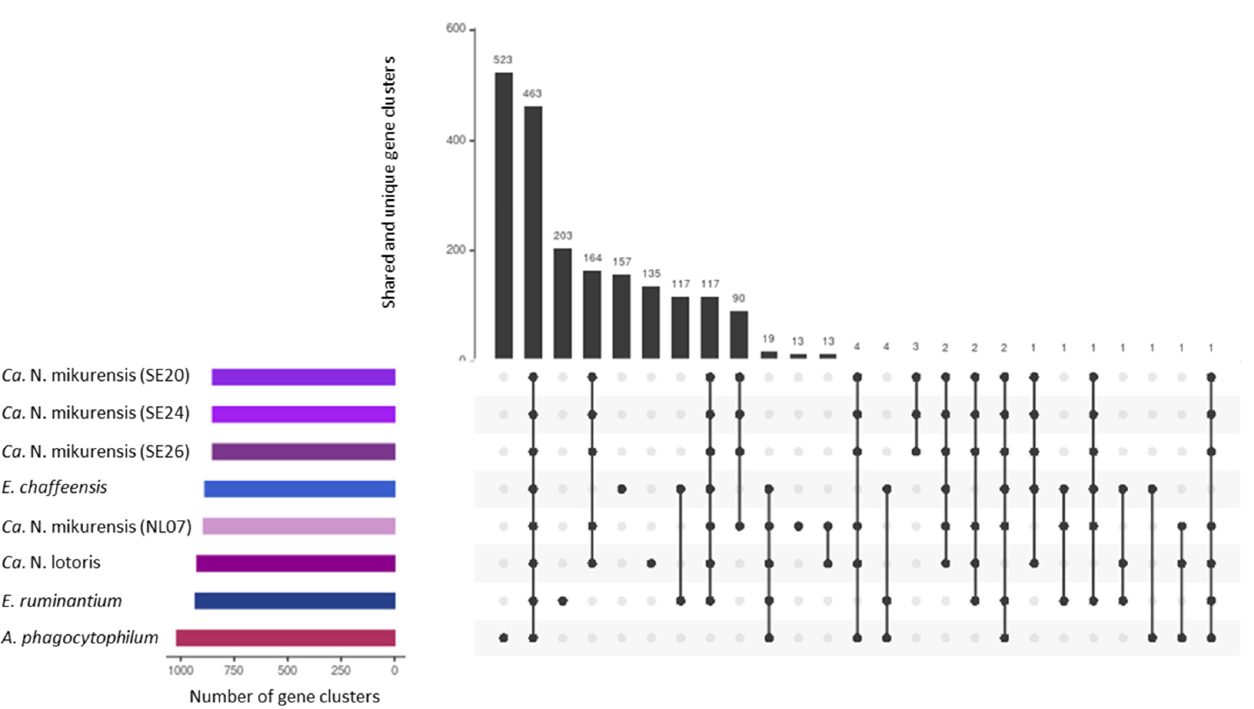
Figure 4. UpSet plot representing the shared and unique gene clusters between NL07 and other members of the Anaplasmataceae family. Black dots indicate the presence of a gene cluster, and connected dots indicate their presence across genomes. The colored horizontal bars represent the amount of gene clusters per genome ranging from 850 to 1018.